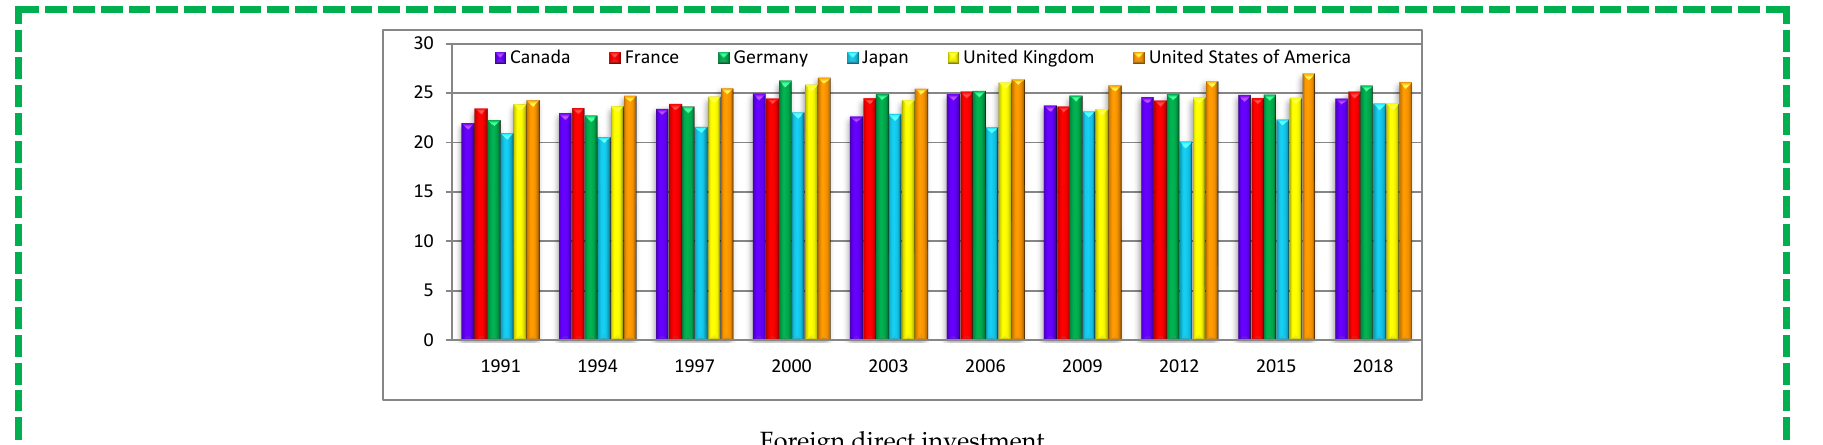
Figure 4. Trend analysis of each variable over a selected period (1991 – 2018).